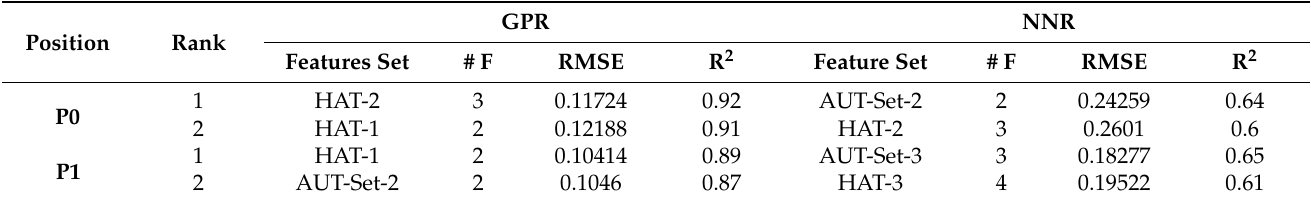
Table 11. Summary of the performance of best SWH regression models for position P0 and P1; ‘#’ denotes the number of